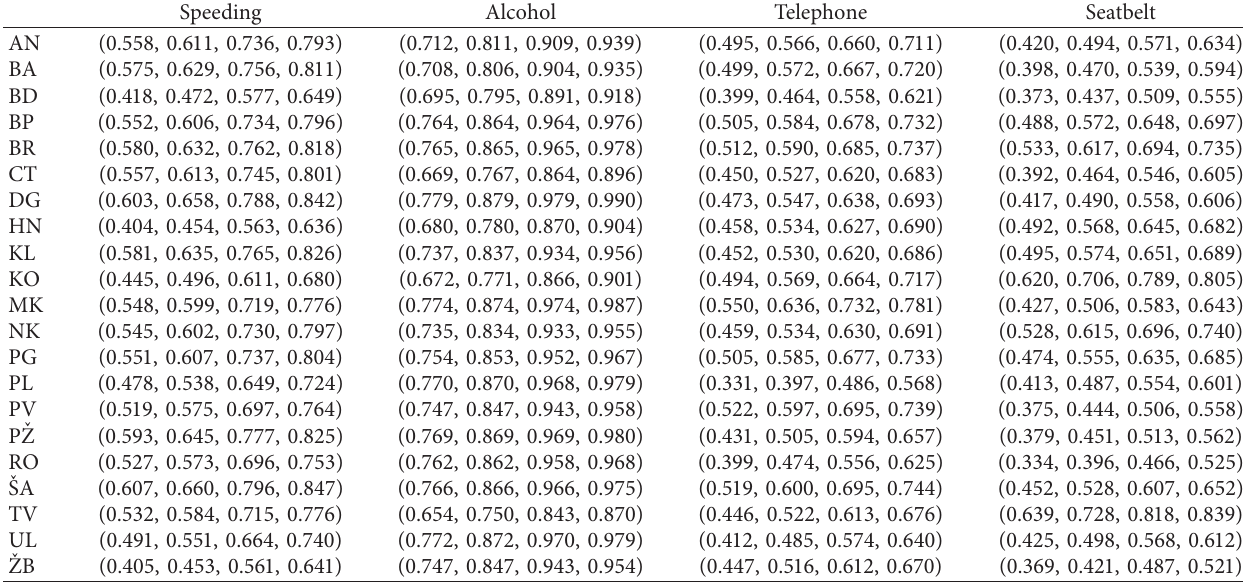
Table 6: Assigned fuzzy numbers of self-reported